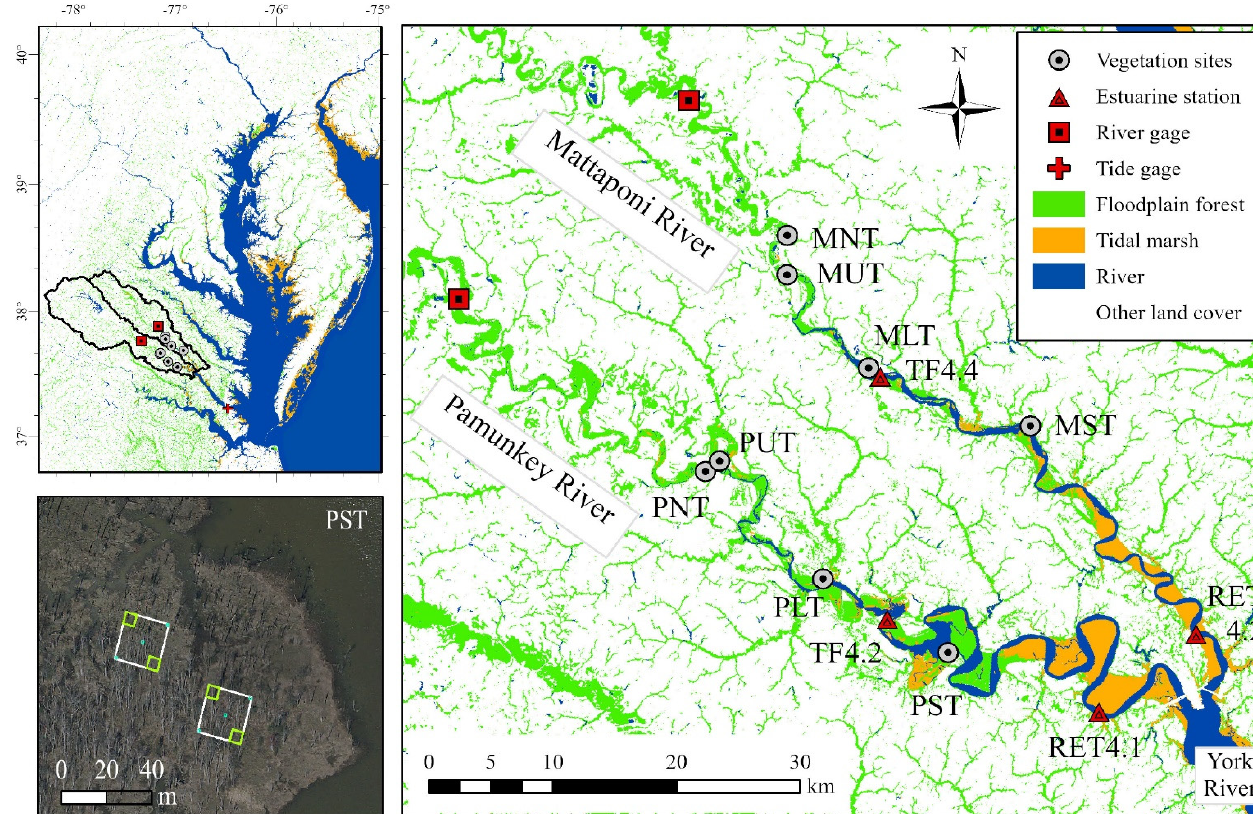
Figure 1. Location of study sites on the Mattaponi and Pamunkey rivers ( right ), location in the Chesapeake Bay watershed of the U.S. Mid-Atlantic ( left top ), and diagram of the vegetation sampling design within each site ( left bottom ; white = plot, green = sapling and shrub subplots, blue = seedling and herbaceous subplots). Vegetation sites: MNT and PNT, MUT and PUT, MLT and PLT, and MST and PST refer to Mattaponi River and Pamunkey River sites, respectively, for nontidal freshwater forested wetland, upper river TFFW, lower river TFFW, and stressed TFFW transitioning to tidal marsh.